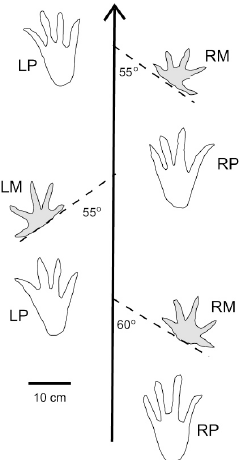
Figure 14. Trackway of modern American Crocodile ( Crocodylus acutus ) showing angular relationships of manus imprints (shaded tracks) to direction of travel (arrow). Adapted from [43].